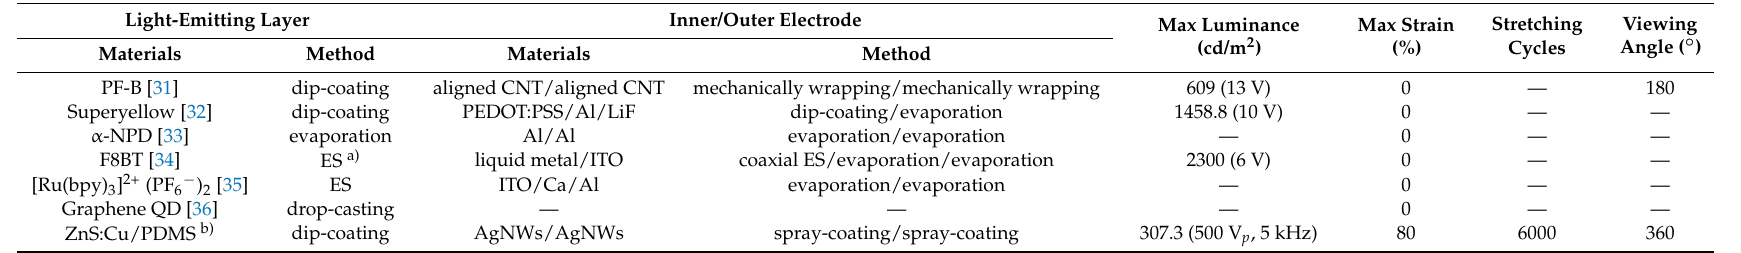
Table 1. Brief summary of performances reported on light-emitting